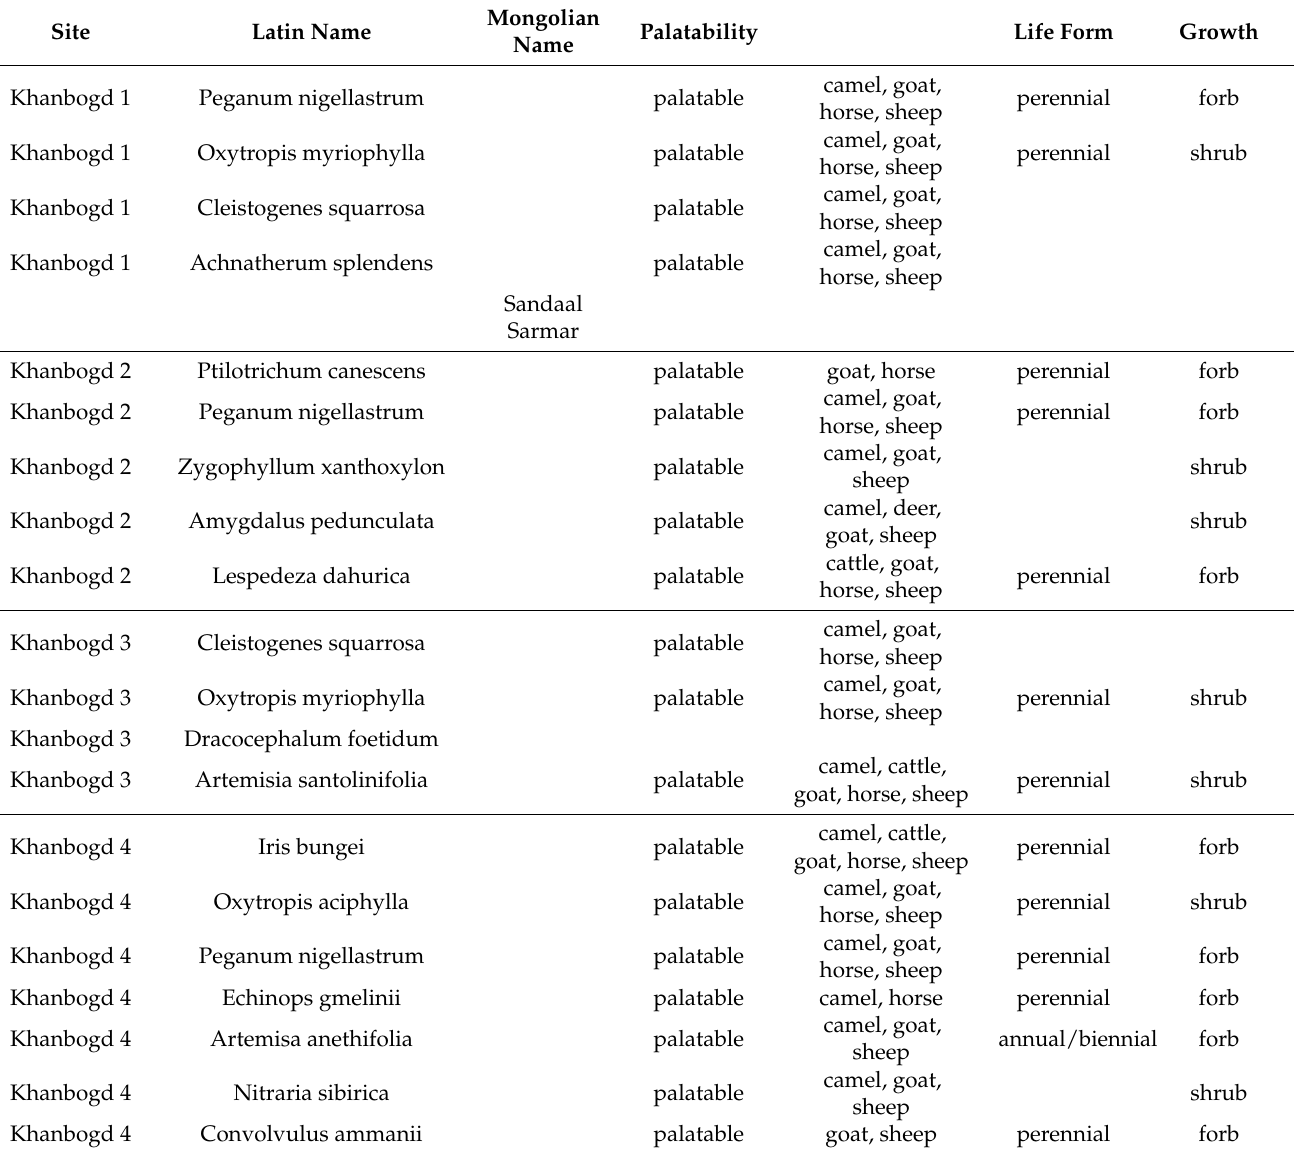
Table A1. Vegetation composition at all